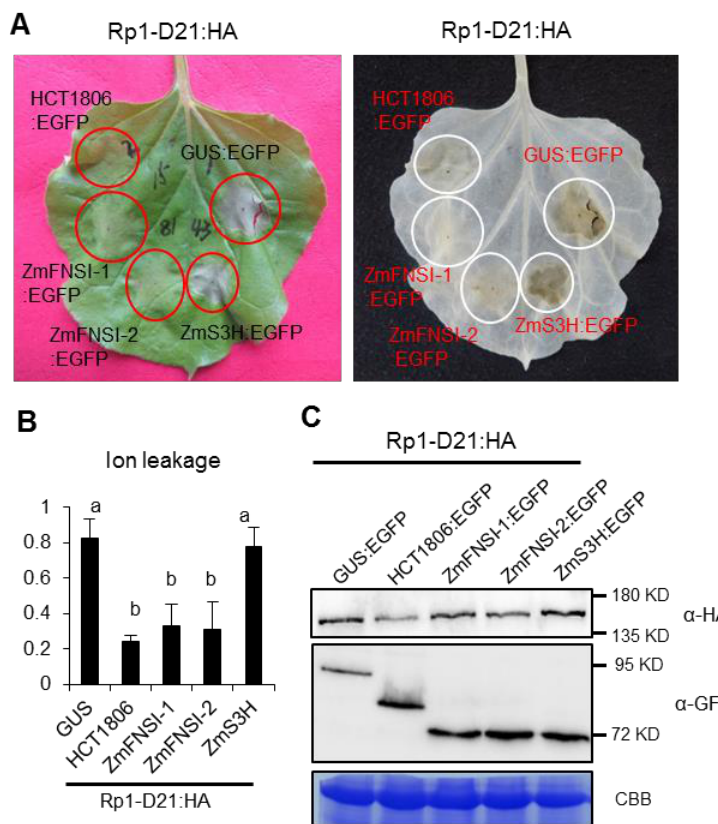
Figure 3. Investigating the function of ZmFNSIs and ZmS3H in Rp1-D21-induced HR. ( A ) ZmFNSIs and ZmS3H were transiently co-expressed with Rp1-D21 into N. benthamiana . The representative leaf was photographed at 3 days after inoculation (left), and the same leaf was cleared by ethanol (right). ( B ) Ion leakage conductivity (average ± standard error (SE), n > 5) was measured at 61 h after co-expression of GUS, HCT, ZmFNSIs or ZmS3H with Rp1-D21. Significant differences ( p < 0.05) between samples are indicated by different letters (a – b). The protocol was measured according to our previous study [38]. ( C ) Total protein was extracted from agro-infiltrated leaves at 30 hpi. Anti-HA was used to detect the expression of Rp1-D21, and anti-GFP was used to detect the expression of GUS, HCT, ZmFNSIs and ZmS3H. Equal loading of protein samples was shown by Coomassie brilliant blue (CBB) staining of Rubisco.